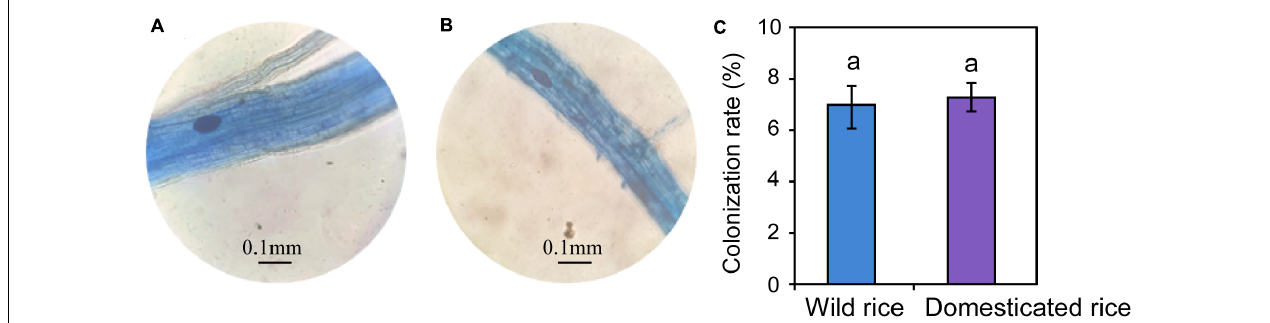
FIGURE 3 | Morphology of the arbuscular mycorrhizal fungi-colonized roots of wild (A) and domesticated (B) rice. Colonization rate of the arbuscular mycorrhizal fungi in roots of the rice plants (C) .